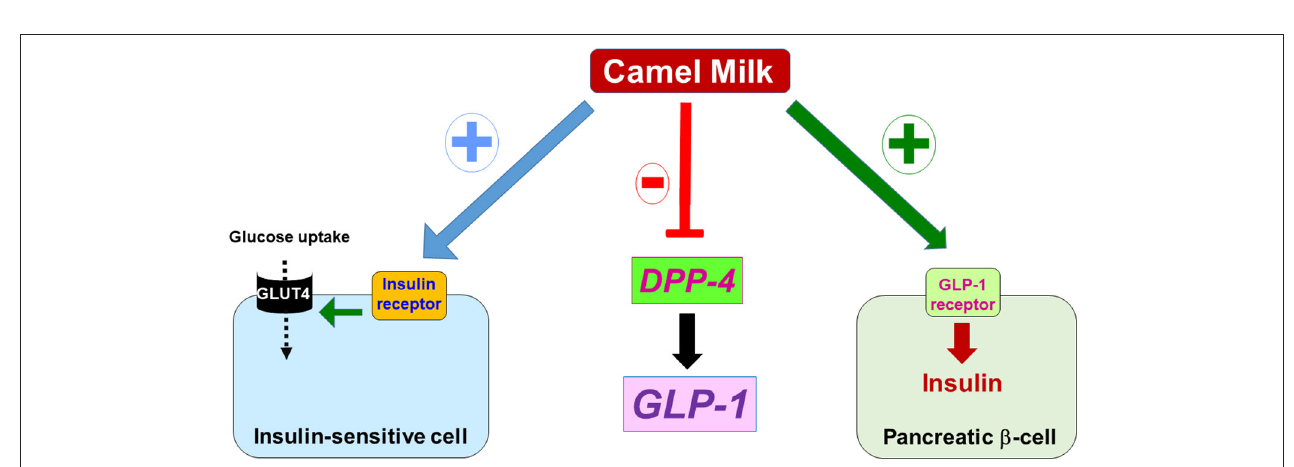
FIGURE 2 | Possible molecular targets of CM in the context of diabetes. At the molecular level, the antidiabetic effects of CM components might seemingly be mediated through targeting and/or activating ( + ) the insulin receptor in the insulin-sensitive cells that leads to glucose uptake via the glucose transporter GLUT4; or activating GLP-1 receptor ( + ) in the pancreatic beta cell that increases insulin synthesis and secretion, or by inhibiting the enzyme DPP-4 which results in the increase of GLP-1 levels controlling insulin synthesis and secretion via binding and activation of its receptor (GLP-1